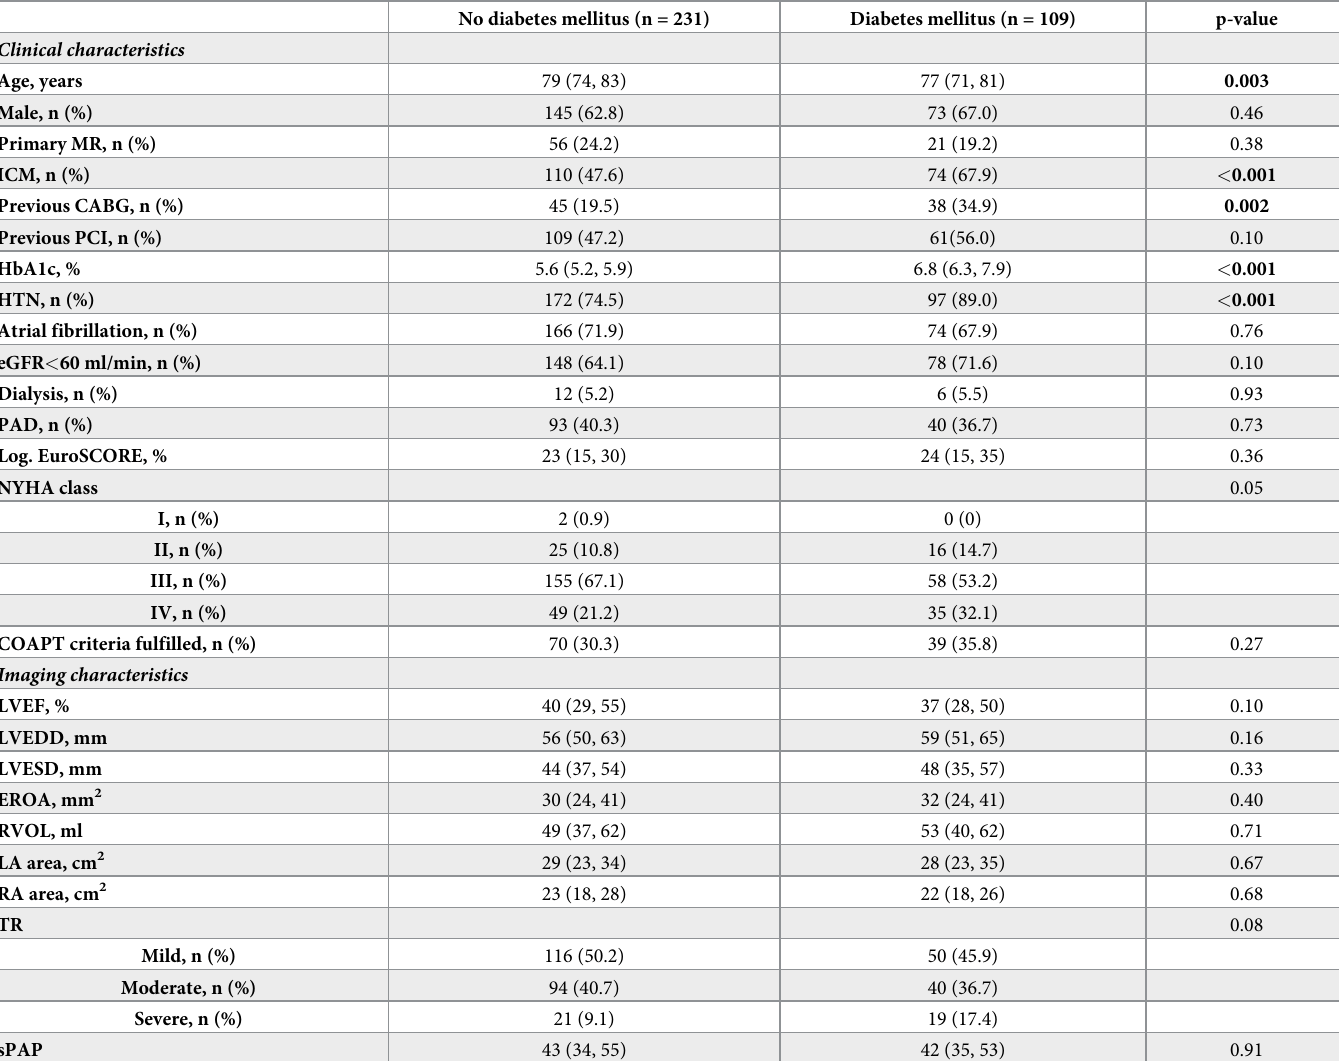
Table 1. Clinical characteristics and echocardiographic parameters of the study population differentiated between patients without and with diabetes mellitus. No diabetes mellitus (n =